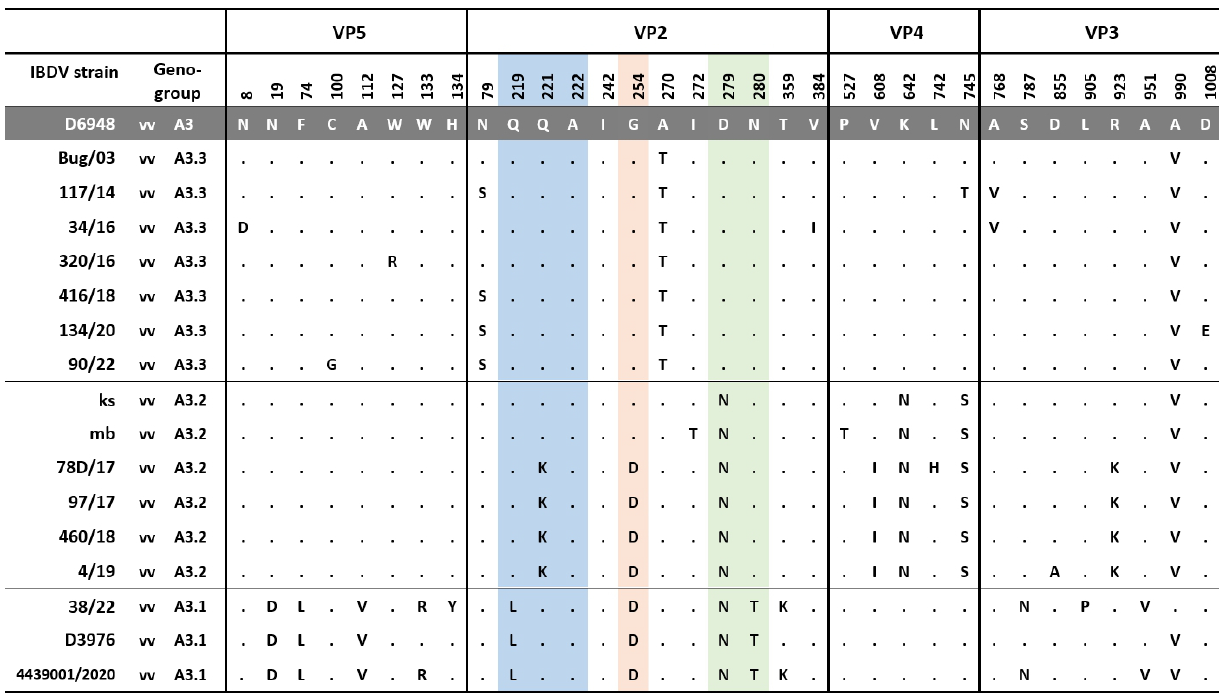
Figure 4. Comparison of amino acid substitutions in viral proteins encoded by segment A between Polish and reference strains. Dots show identity with D6948. The amino acids forming the P BC (aa 219–224), P DE (aa 249–254), and P FG (aa 279–284) loops of the VP2 hypervariable domain are highlighted in blue, orange, and green, respectively. Abbreviations: vv—very virulent, A—alanine,